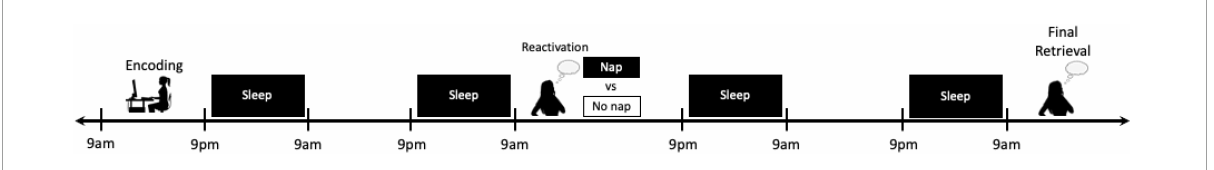
FIGURE7 Schematics of a potential study protocol designed to target the effects of sleep manipulation on post-retrieval, reconsolidation processing of emotional memory. In the typical reconsolidation study design, the encoding, reactivation, and retrieval sessions typically take place days apart with full nights of sleep in between, allowing for the investigation into the specific effects of sleep manipulation after reactivation using nap or sleep deprivation protocols. While sleep has been shown to be an important component of the reconsolidation process in other forms of declarative memory, investigations into the effects on emotional episodic memory remain